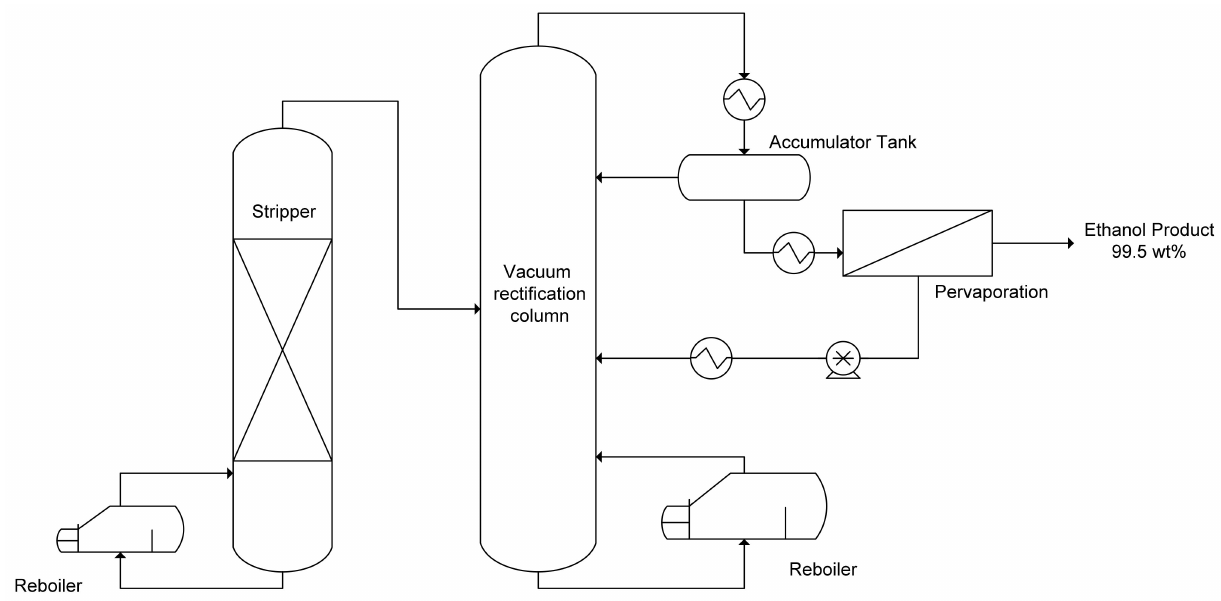
Figure 5. A simultaneous distillation/pervaporation facility for ethanol recovery from fermenters. (Reproduced with permission from Baker, R.W, Membrane Technology and Application; published by John Wiley and Sons,